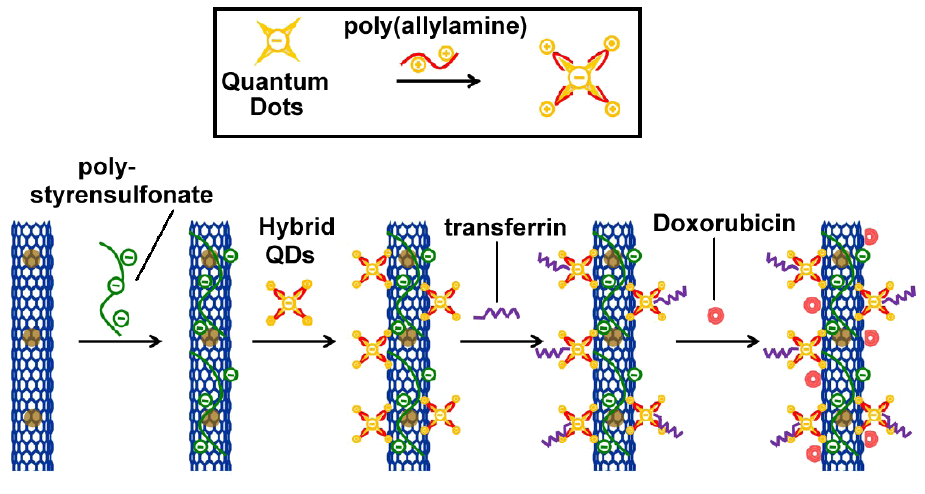
O @CNT-HQDs-Trf 3 4